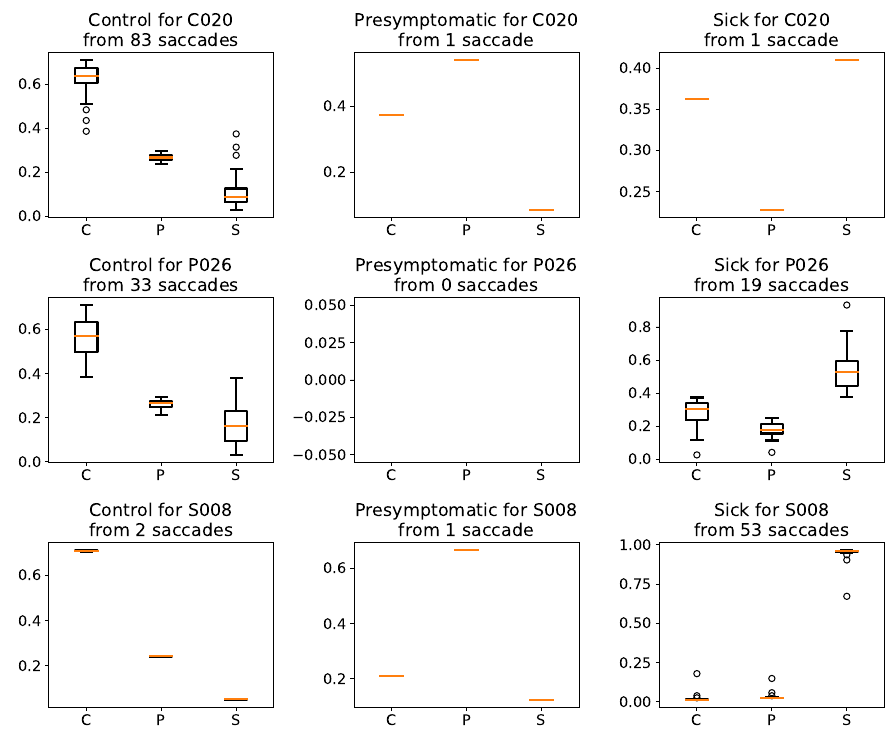
Figure 6. Box plots of 3 registers corresponding to each class of the problem: first row corresponds to a control register, second refers to a presymptomatic register and third to a sick register. For each register, mean and standard deviation results are outlined for saccades with the labels given by the MCDE approach, as described in Algorithm